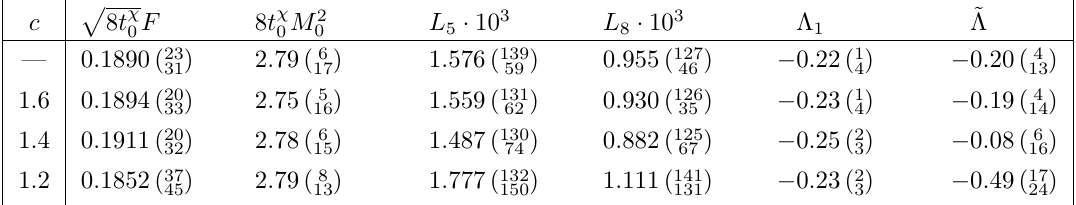
Table 14. LECs obtained for the fits detailed in table 13. The dimensionful LECs are given in units of the gradient flow